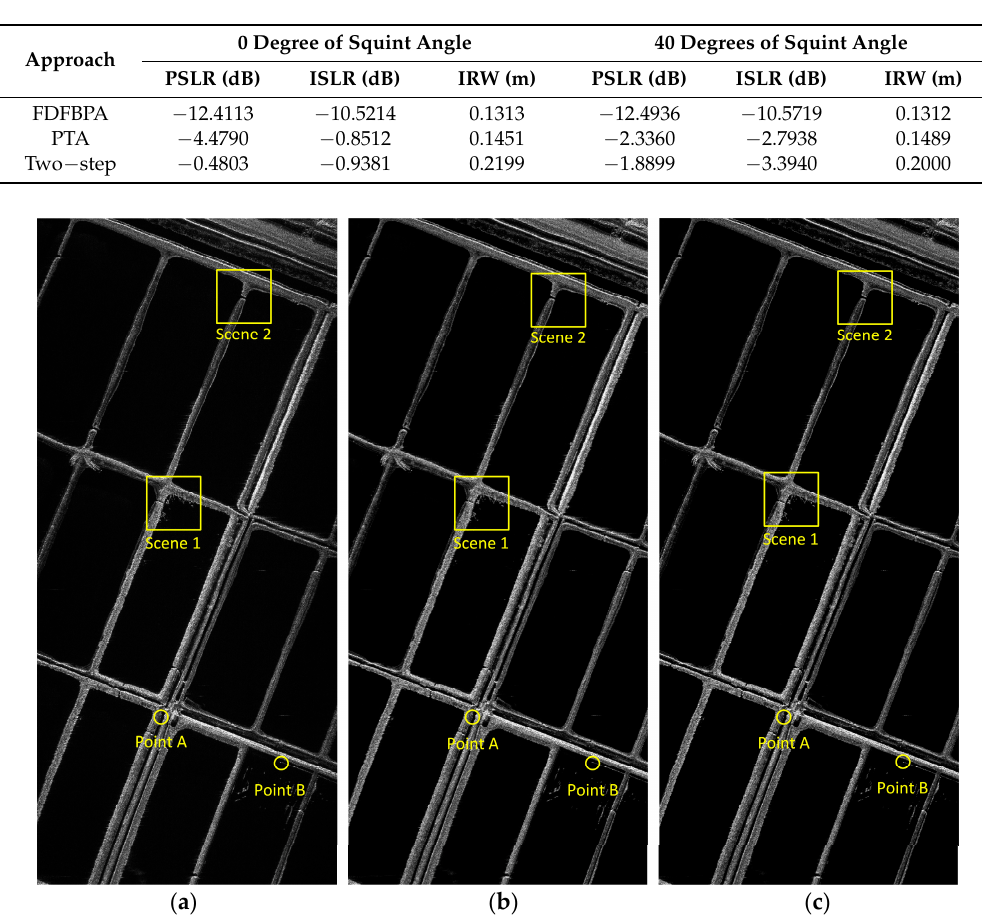
Figure 6. Azimuth impulse response curve comparison of FDFBPA, 25% overlapped PTA and Two-